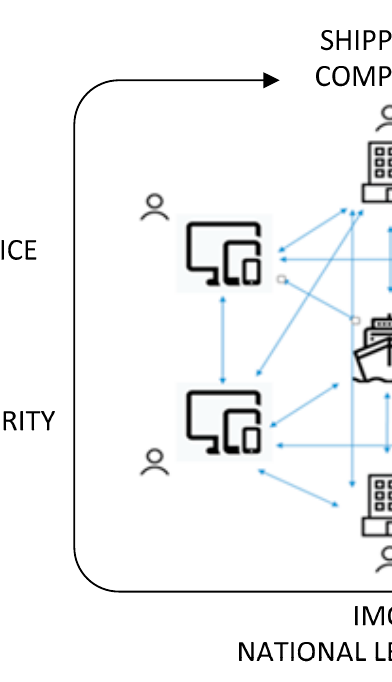
Figure 2. Structure of shipping information-sharing platform based on the blockchain (BCT). Source: Authors.